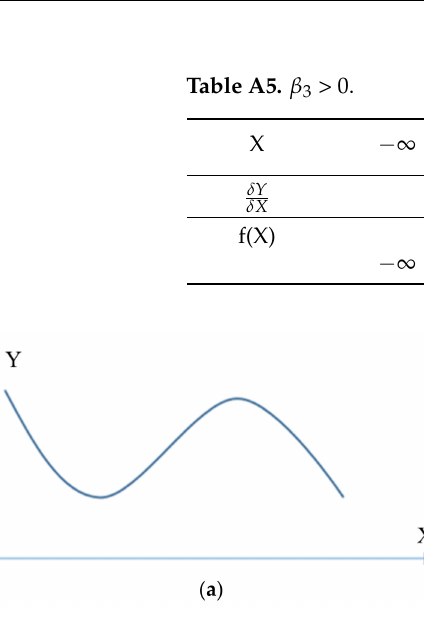
Figure A2. The cubic shape when Equation (A1) has two turning points: ( a ) β 3 < 0; ( b ) β 3 > 0.